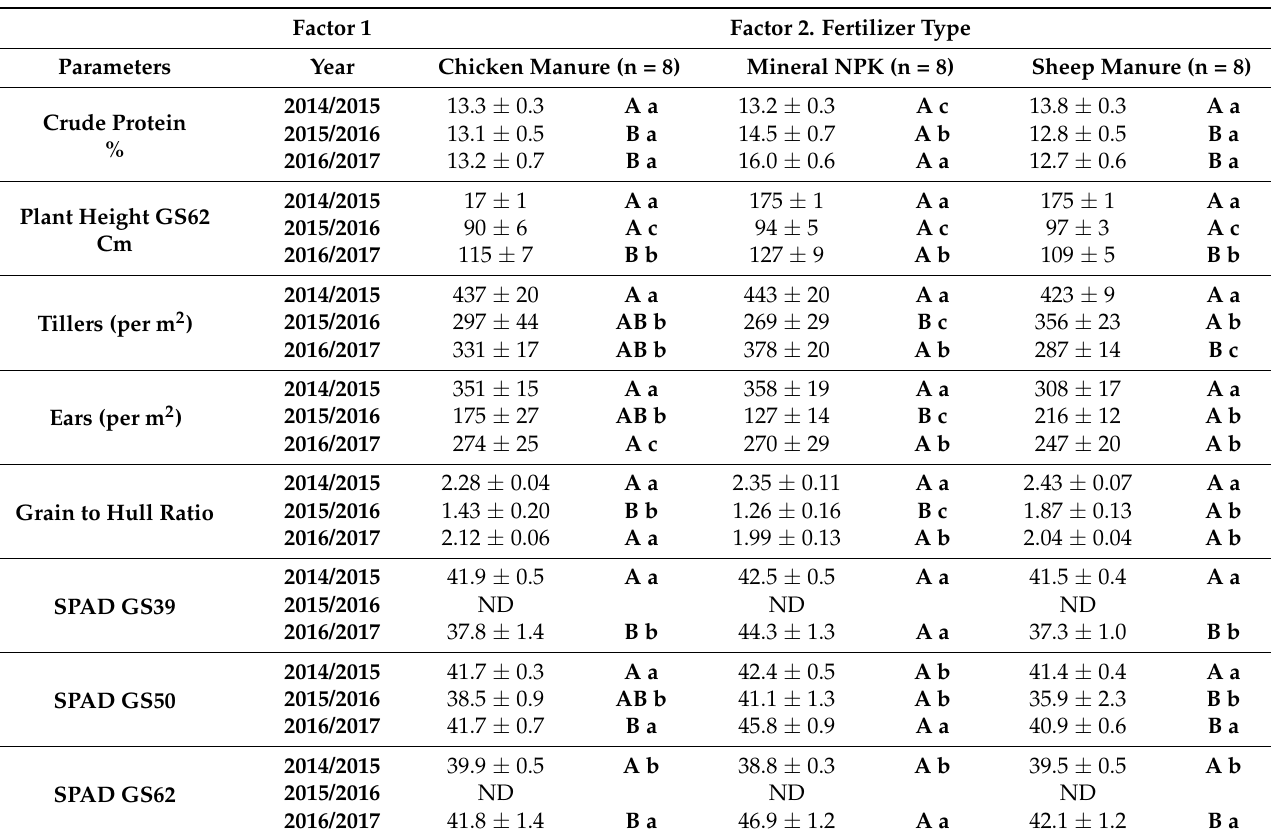
Table S1). Significant 2-way interactions between season and fertilizer type were detected and 3 and Table S1). Table 3. Interaction means ± SE for the effects of growing season (2014/2015, 2015/2016 and 2016/2017) and fertilizer type (chicken manure, mineral NPK and sheep manure) on spelt wheat (variety Rubiota) grain crude protein content and yield-related growth